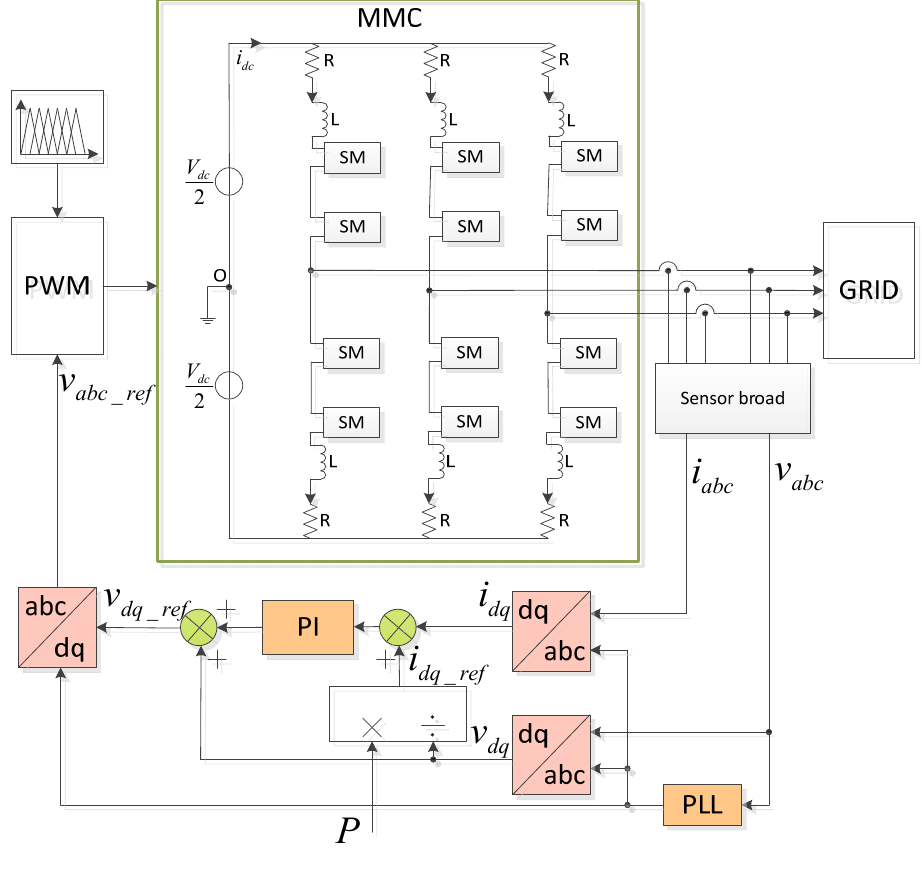
Figure 5. Block diagram of the grid-side MMC control strategy. Table 7. Specifications of the MMC